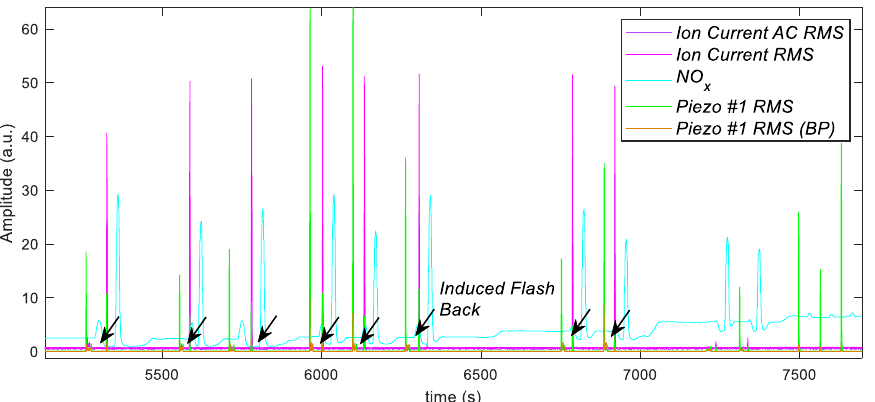
Figure 15. Time sequences of the measured parameters during the test. Piezo #1 RMS and Piezo #1 RMS (BP): scaled pressure measurements from the sensor placed inside the combustor, RMS value and RMS value in a narrower bandwidth, respectively; Ion Current RMS and Ion Current AC RMS: measured ion current expressed in RMS and RMS of the AC component, respectively; NOx: NOx normalized concentration